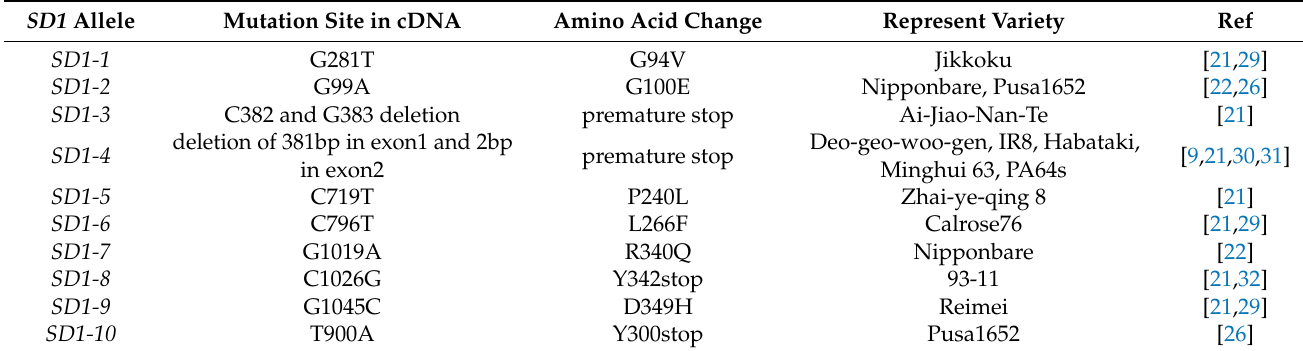
Table 1. Allele diversity of SD1 and their representative